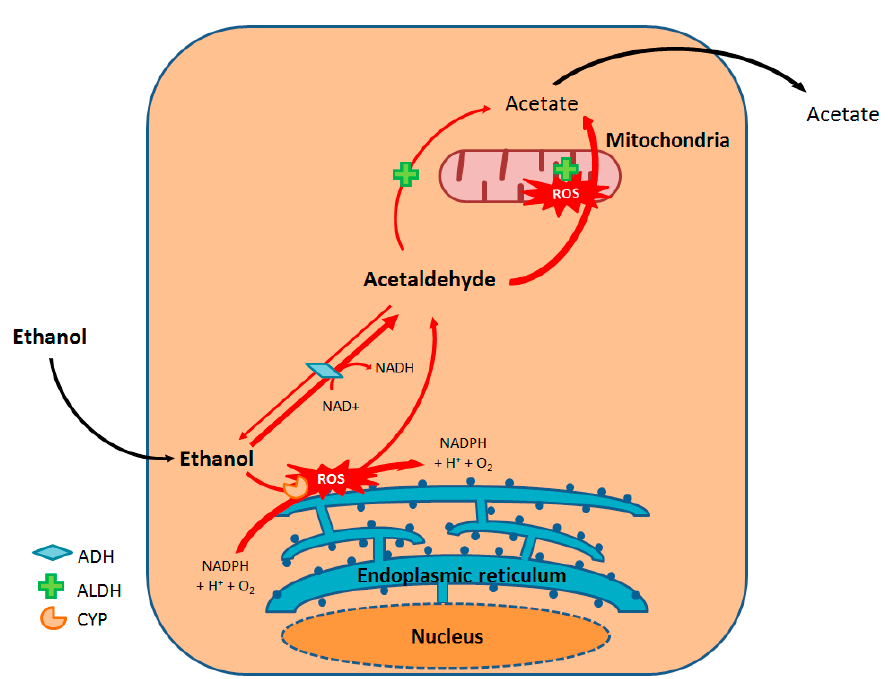
Figure 2. Oxidative metabolism of ethanol. ADH: Alcohol dehydrogenase; ALDH: Aldehyde dehydrogenase; CYP: Cytochrome P450.